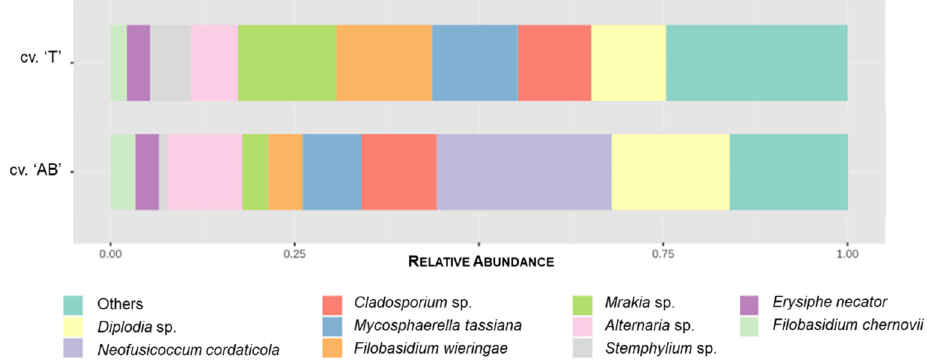
Figure 9. Relative abundance of the top 10 fungal species according to the cultivar (’T’—Trincadeira; ‘AB’—Alicante Bouschet), considering the 215 OTUs assigned to the genus or species level. The remaining species are grouped in “Others”.